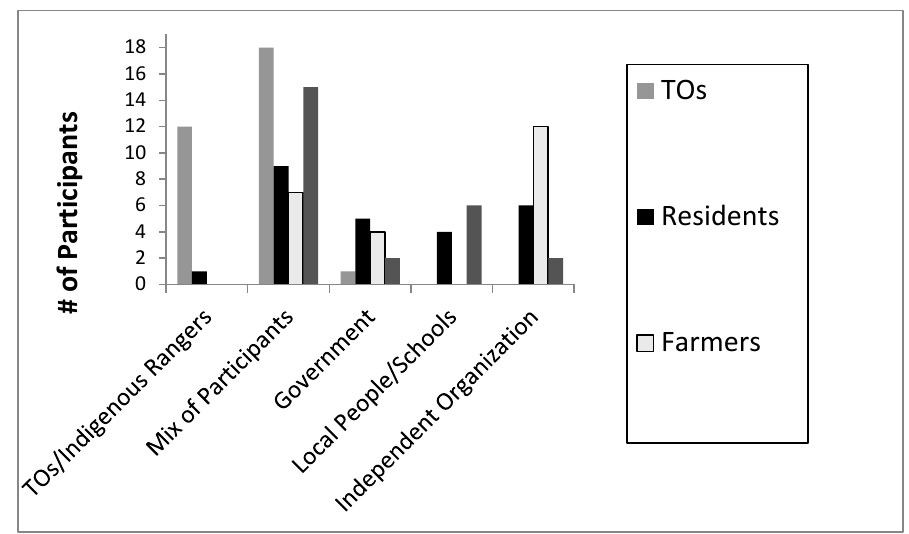
Figure A14. Suggestions for who should conduct sampling activities in the basin.